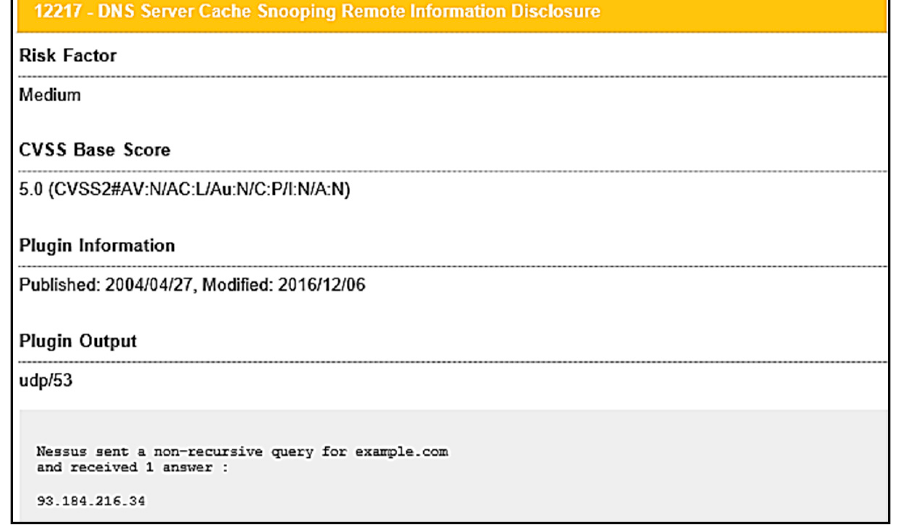
Figure 6. DNS server cache snooping vulnerability.